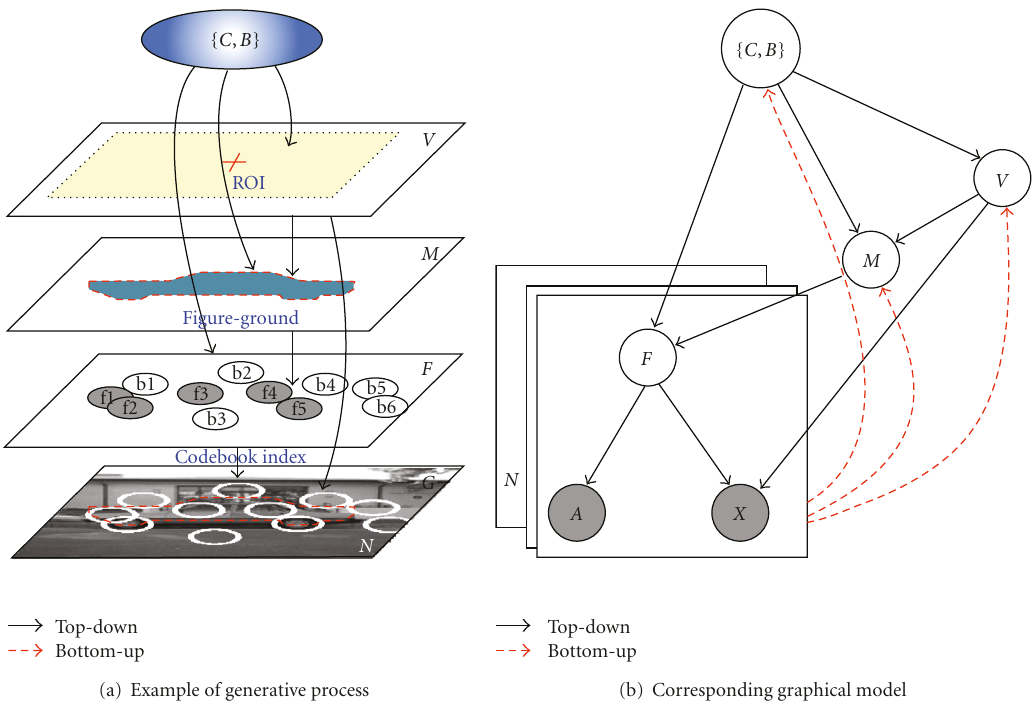
Figure 11: (a) Generative framework for simultaneous object categorization and figure-ground segmentation in cluttered environment, (b) corresponding representation by directed graphical model (Bayesian